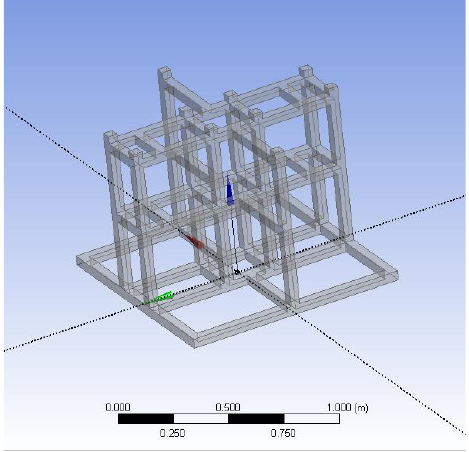
Figure 1. Overall model of the frame.